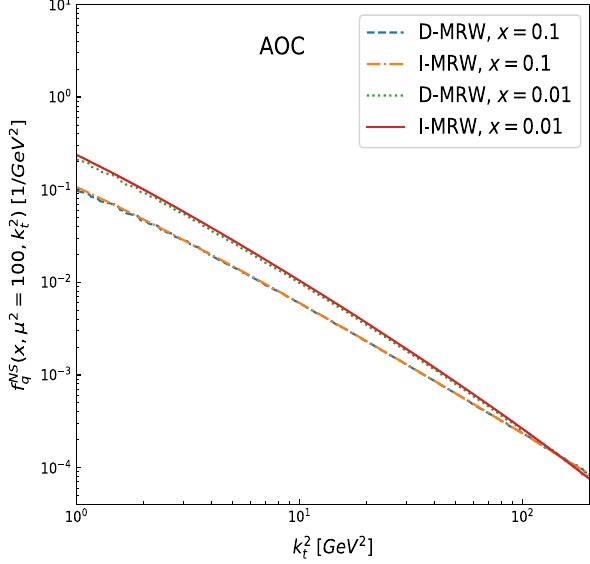
Fig. 5 This figure shows the comparison of the non-singlet quark MRW UPDF employing AOC cutoff-dependent PDF. The differential (integral) UPDFs of the Eq. (15) is denoted by D-MRW